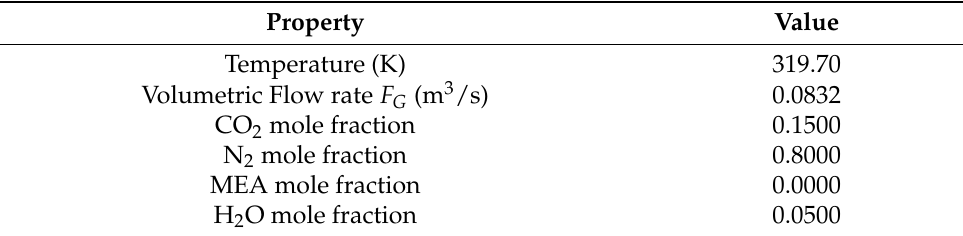
Table 3. Nominal flue gas